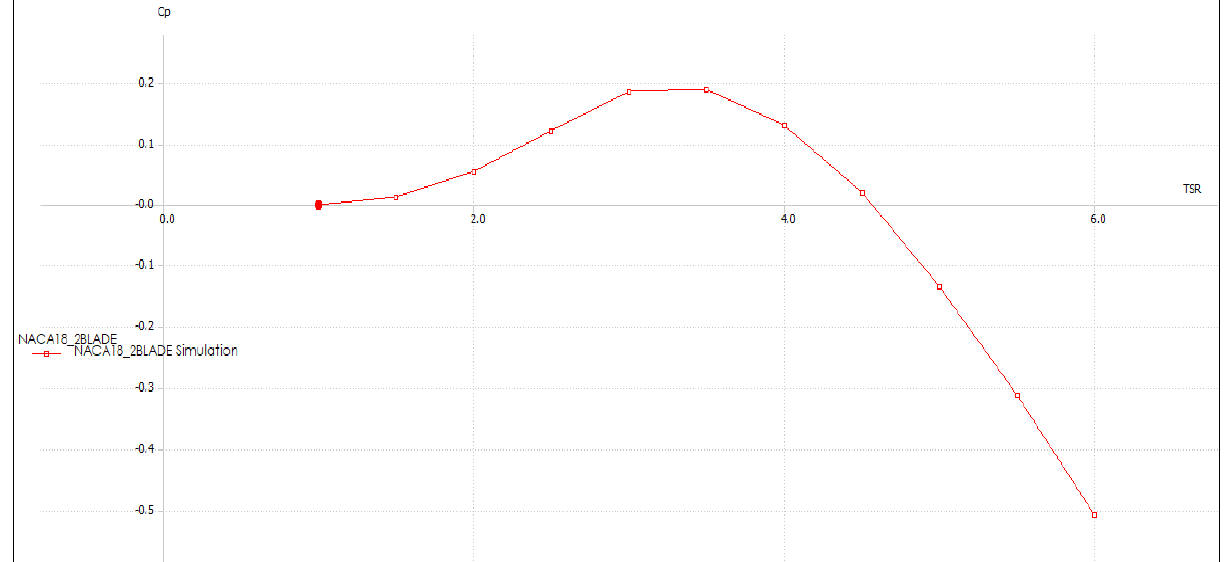
Figure 19. Cp vs TSR for 2 Bladed